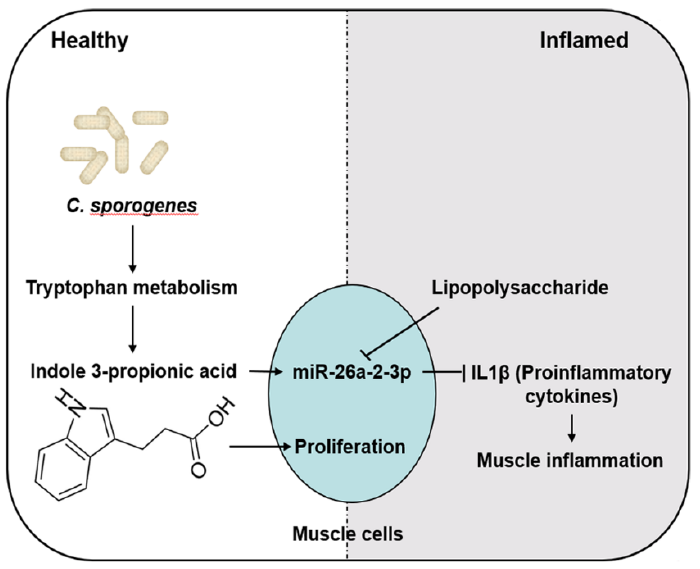
Figure 7. The potential molecular mechanisms of IPA-promoted muscle cell proliferation and reduced inflammation. Briefly, C. sporogenes produces anti-inflammatory metabolite IPA by changes in tryptophan metabolism. IPA promotes muscle cell proliferation by activating the myogenic regulatory factor signaling pathway. Moreover, IPA reduced cell inflammation and ensuing proinflammatory factors’ secretion through activating anti-inflammatory miR-26A targeting IL-1 β in C2C12 cells. Those decreased proinflammatory cytokines from the muscle cells would reduce the occurrence of muscle inflammation.